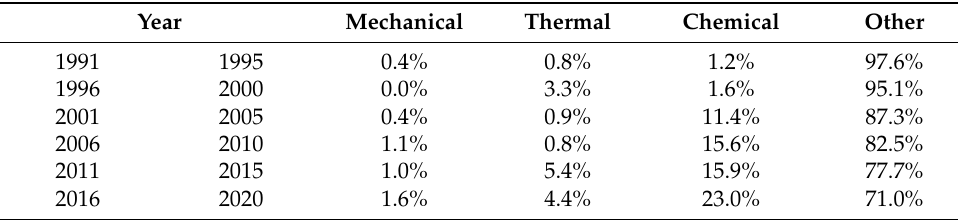
Table 8. Distribution of backward chemical recycling citations per type of patent